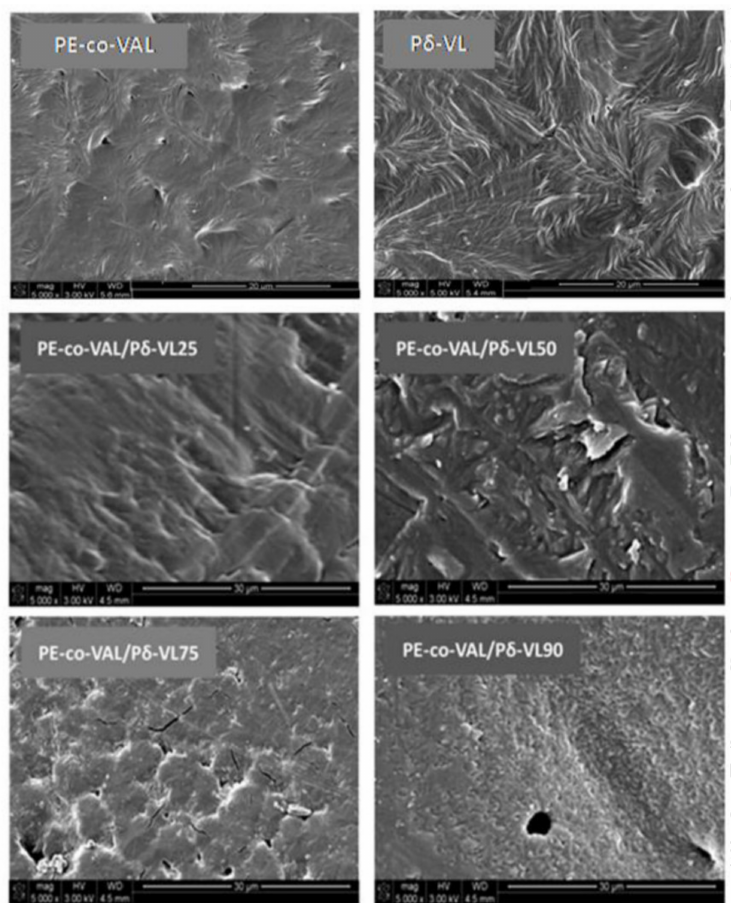
Figure 8. SEM micrographs of the surface morphologies of PE- co -VAL/P δ -VL blends with different